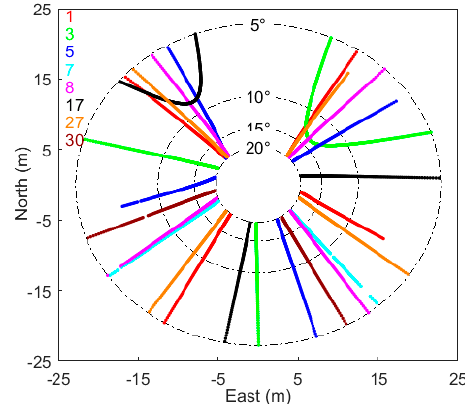
Figure 4. Specular GPS multipath reflected point tracks at p025 (DOY 2015-312). Red, green, blue, cyan, purple, black, orange, and brown lines represent specular reflected point tracks of GPS L2C signals from satellites 1, 3, 5, 7, 8, 17, 27, 30, respectively.